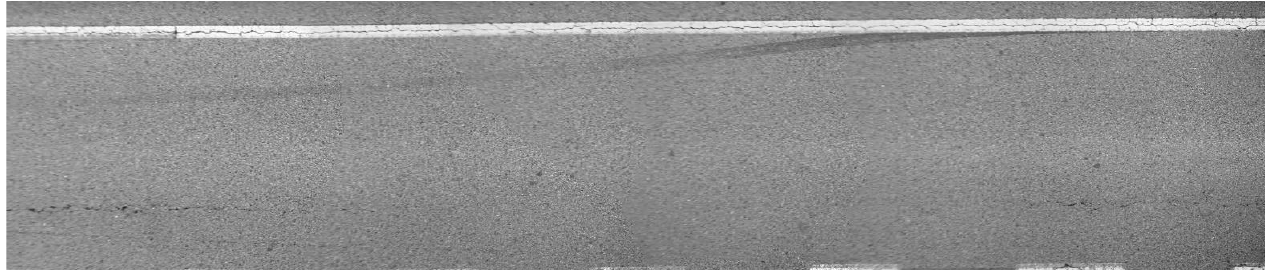
Figure 9. Sample of a panoramic image.